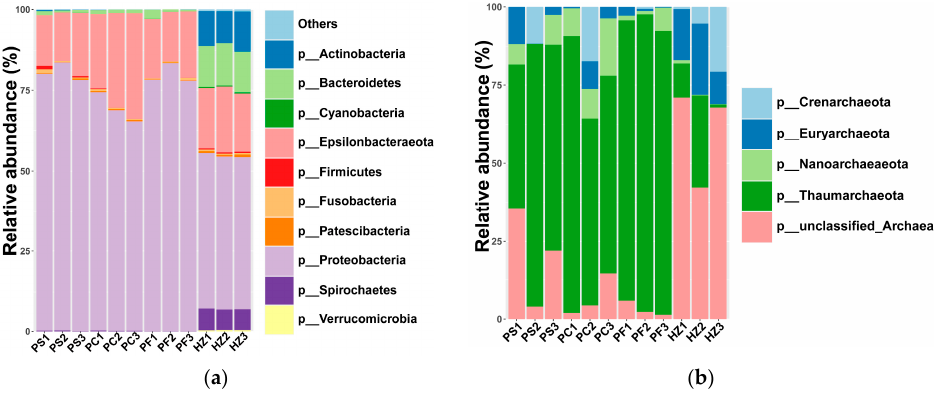
Figure 2. Stacked bar graphs showing the most common bacterial ( a ) and archaeal ( b ) phyla obtained using different microbial DNA enrichment methods. The top 10 bacterial phyla were shown in detail, and the rest are represented by “others”.